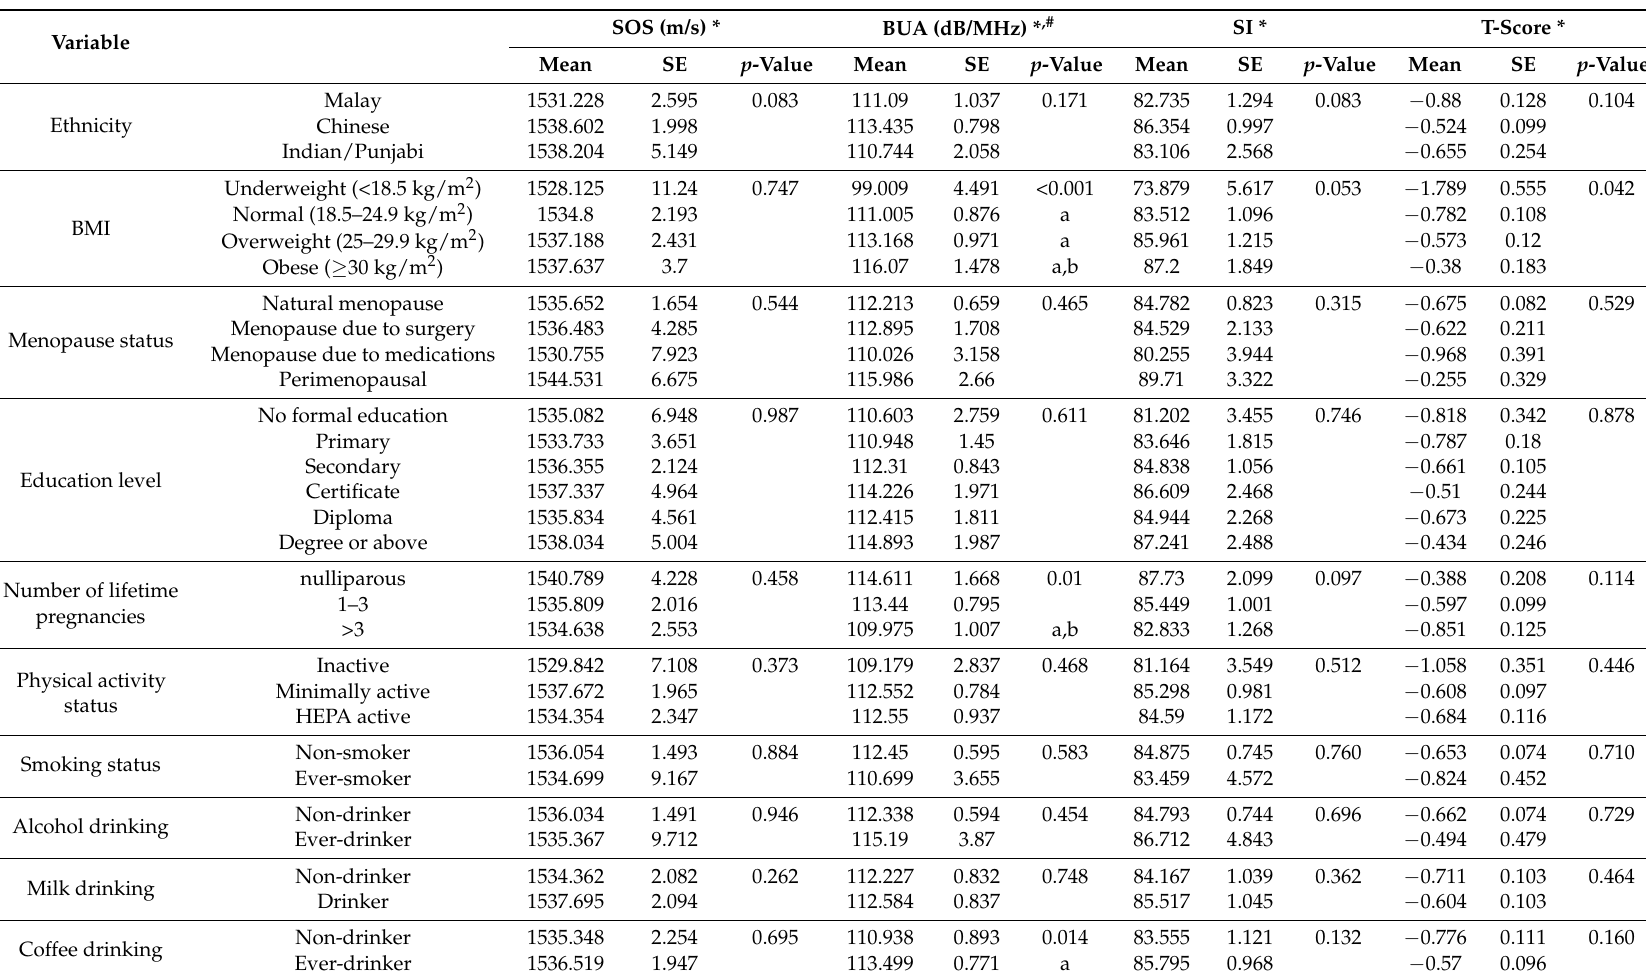
Table 2. Quantitative ultrasound (QUS) indices of the categorical variables. SOS = speed of sound; BUA = broadband ultrasound attenuation; SI = stiffness index.